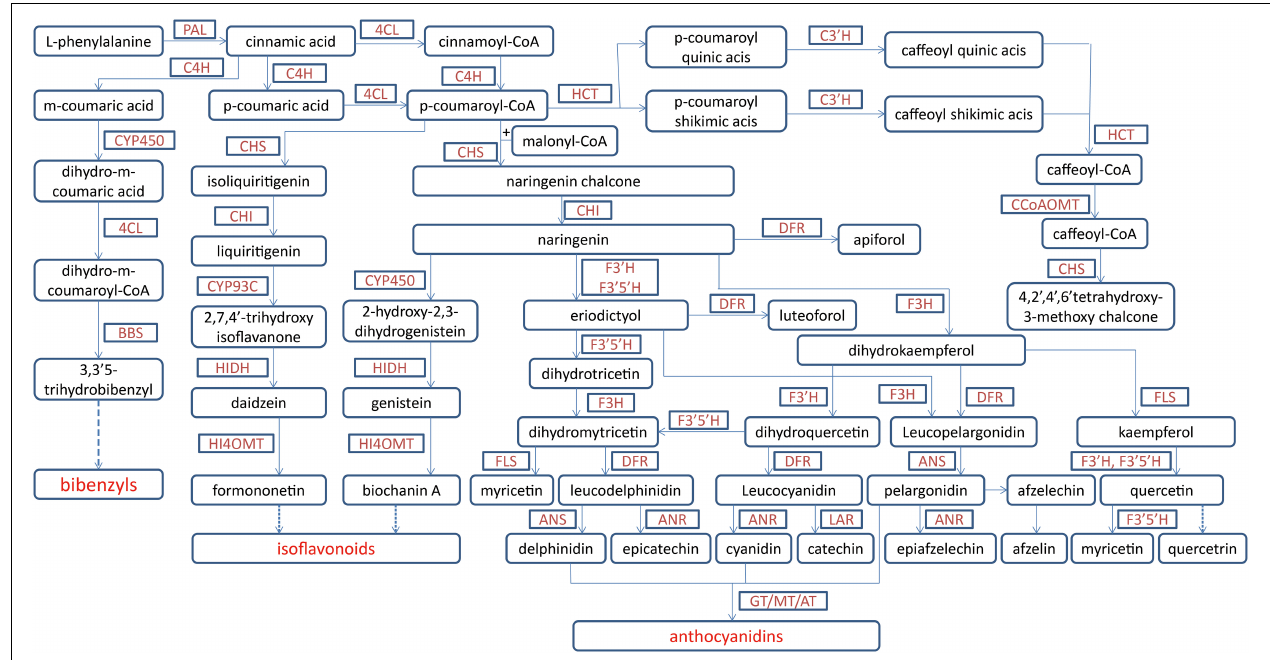
FIGURE 3 | The biosynthetic pathway for phenols in Dendrobium officinale . The biosynthesis for main phenols includes anthocyanidins, isoflavonoids, flavones, flavonols and bibenzyls from phenylalanine. 4CL, 4-coumarate-CoA ligase; ANR, anthocyanidin reductase; ANS, anthocyanidin synthase; AT, acyltransferase; BBS, bibenzyl synthase; C3 (cid:48) H, 5-O-(4-coumaroyl)-D-quinate 3 (cid:48) -monooxygenase; C4H, cinnamate 4-hydroxylase; CCoAOMT, caffeoyl-CoA O-methyltransferase; CHI, chalcone isomerase; CHS, chalcone synthase; CYP450, cytochrome P450-dependent monooxygenase; DFR, dihydroflavonol-4-reductase; F3 (cid:48) 5 (cid:48) H, flavonoid 3 (cid:48) ,5 (cid:48) -hydroxylase; F3 (cid:48) H, flavonoid 3 (cid:48) -monooxygenase; F3H, flavonoid 3-hydroxylase; FLS, flavonol synthase; GT, glycosyltransferase; HCT, quinate O-hydroxycinnamoyltransferase; HI4OMT, hydroxy-isoflavanone-4- O-methyltransferases; HIDH, tri-hydroxy-isoflavanone dehydratase; LAR, leucoanthocyanidin dioxygenase; MT, methyltransferase; PAL, phenylalanine ammonia